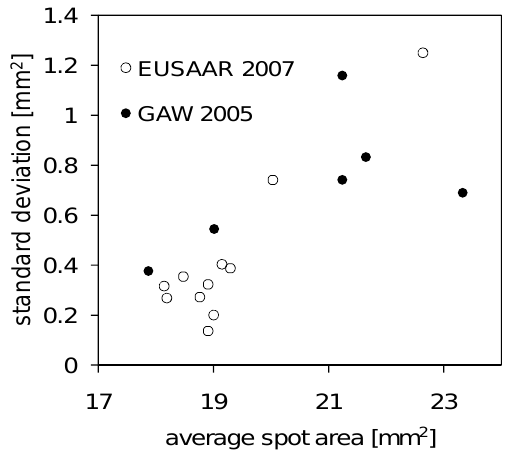
Fig. 5. Standard deviation of PSAP spot area versus average spot area. Each point is for one PSAP. The nominal spot area given by the manufacturer is 17.85mm 2